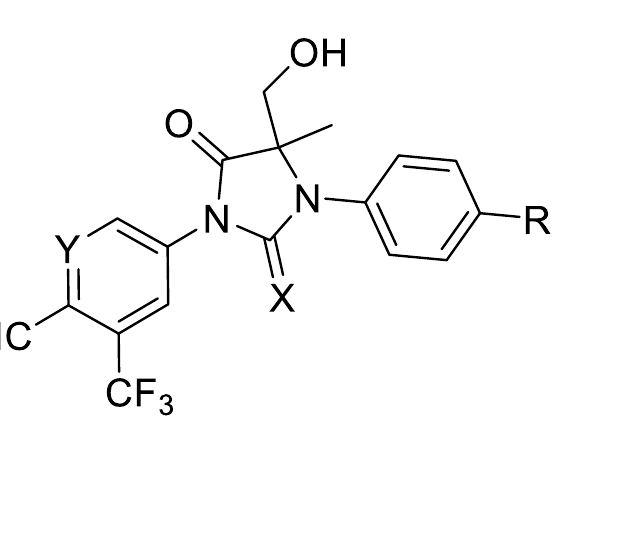
Figure 2. Design of nonsteroidal androgen receptor antagonists.